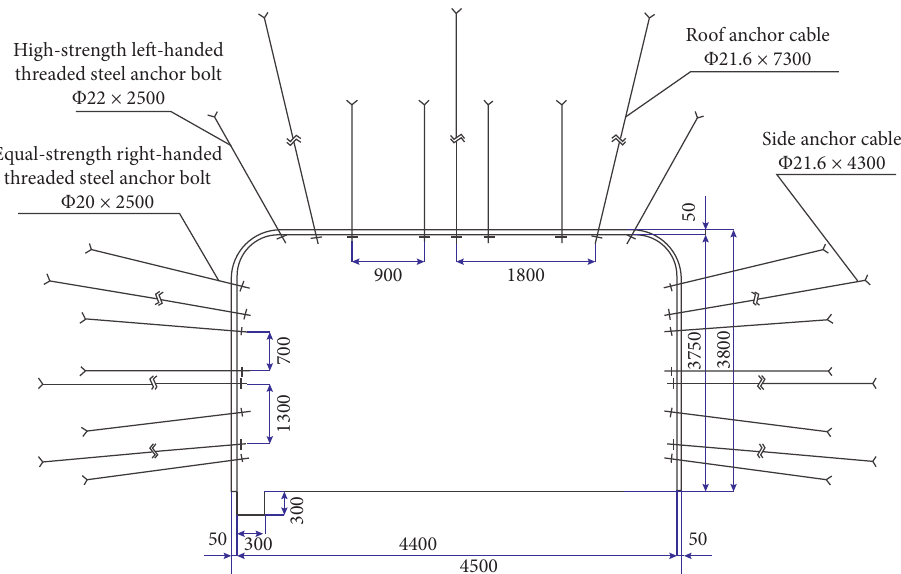
Figure 9: Design of reinforced support in the